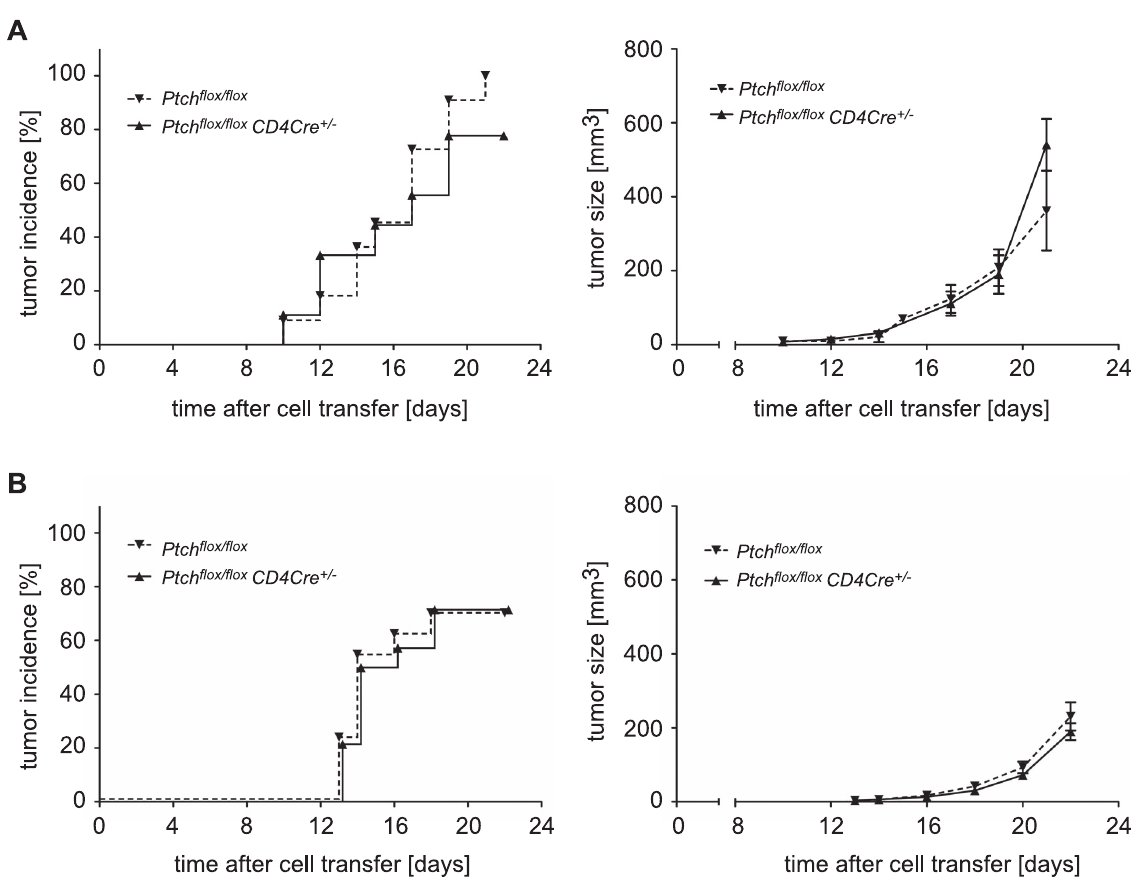
Figure 8. Tumor incidence and size after inoculation of B16 melanoma cells. C57BL/6 mice were inoculated with 10 4 B16-F10 melanoma cells into the right flank and tumor growth was monitored over a period of three weeks. The incidence of palpable tumors (left panel) and the mean tumor size 6 SEM (right panel) are depicted for both experimental setups. (A) Results of tumor incidence and size are shown for eleven Ptch flox/flox control and nine Ptch flox/flox CD4Cre + / 2 mutant C57BL/6 mice in which tumorigenesis had been induced without additional manipulation. (B) To generate protective immunity, C57BL/6 mice were vaccinated with 10 6 irradiated B16-F10 cells together with adjuvant subcutaneously into the left flank. Ten days later the vaccinated mice were challenged with 10 4 viable B16-F10 cells subcutaneously into the right flank. Tumor incidence rate and mean tumor size 6 SEM are shown for fourteen Ptch flox/flox and Ptch flox/flox CD4Cre + / 2 mice each. Statistical analysis of tumor incidence and size was performed by Mann Whitney test and not found to be different between both genotypes.